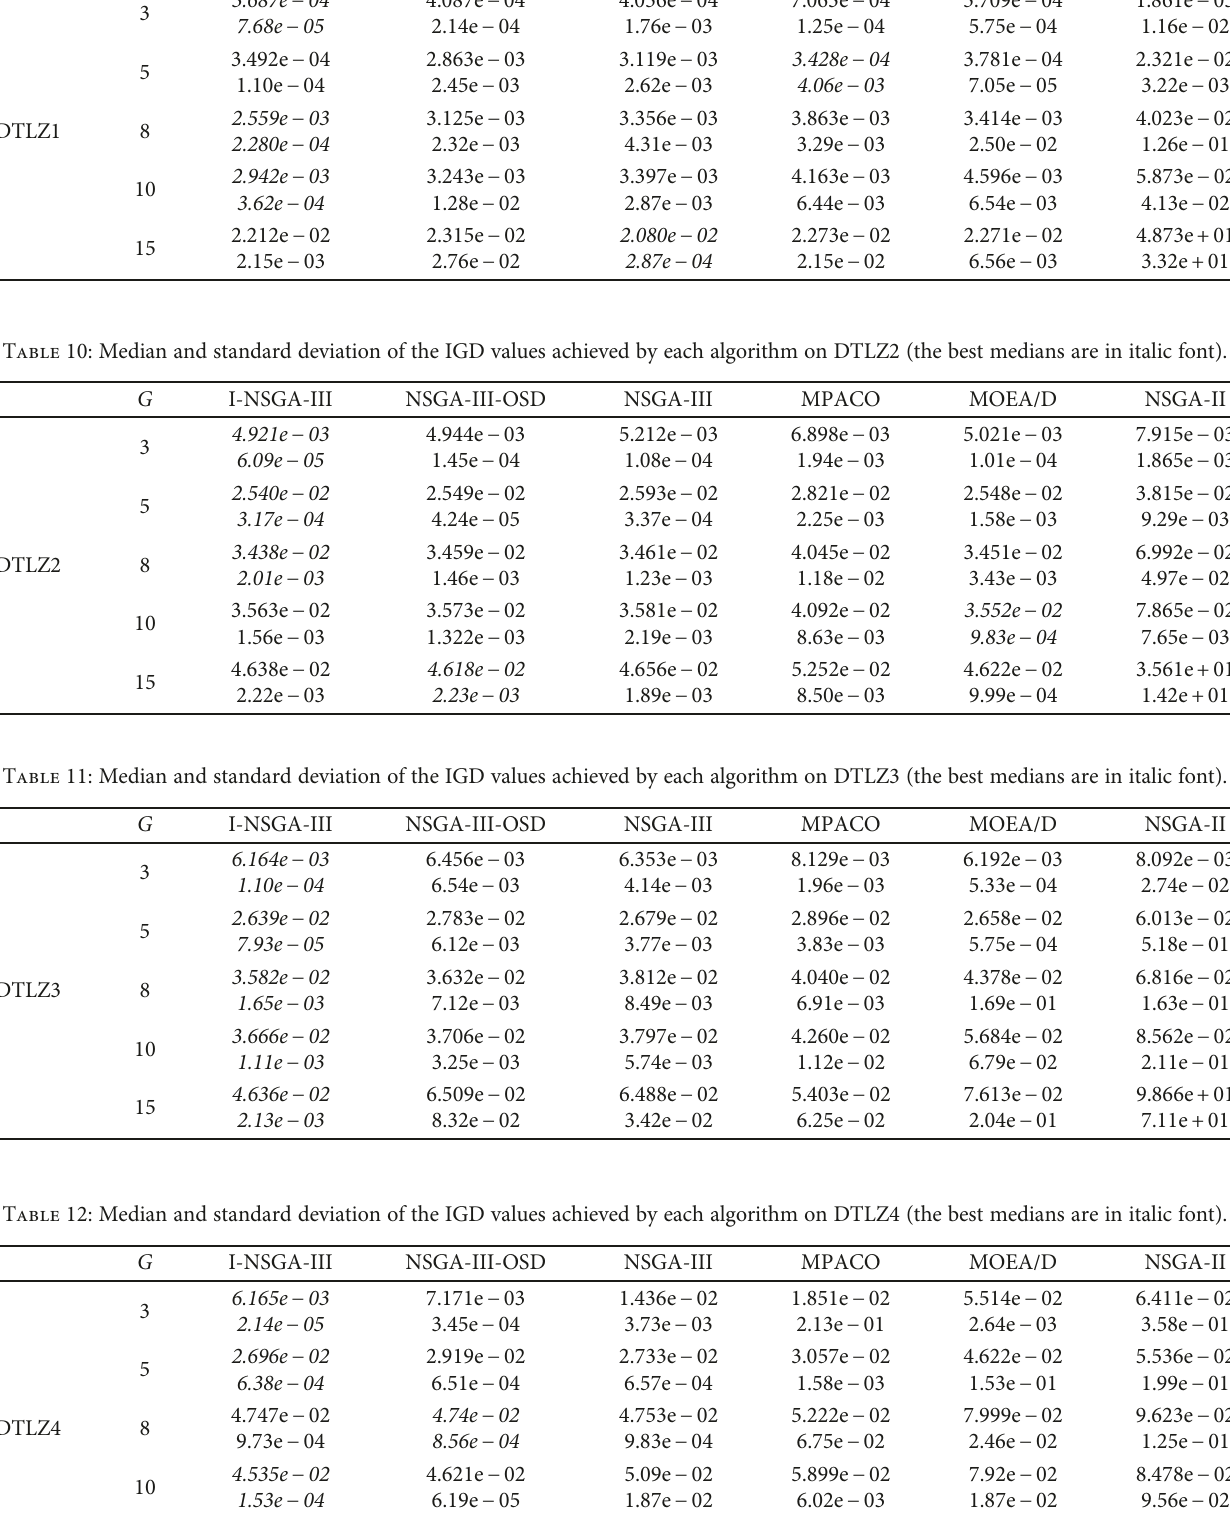
Table 9: Median and standard deviation of the IGD values achieved by each algorithm on DTLZ1 (the best medians are in italic font). G